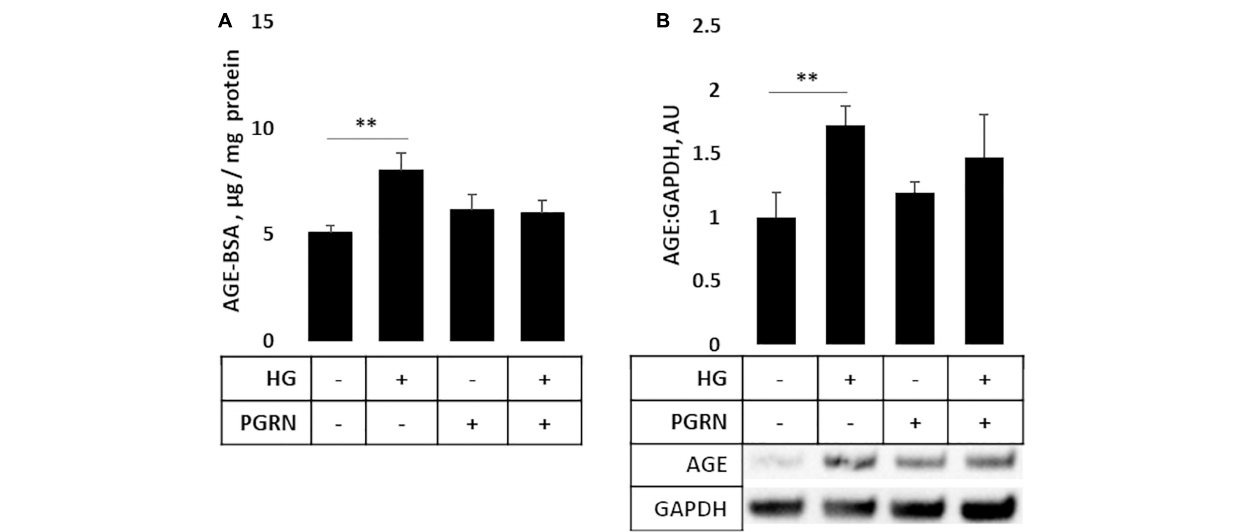
FIGURE 5 | Protein turnover in cortical neurons treated with high glucose and PGRN. (A) Cells incubated with high-glucose medium and progranulin for 72 h were treated with 50 µ g of AGE-BSA during the remaining 6 h before harvest. Remaining AGE-BSA was measured by fluorescence (360 nm excitation, 460 nm emission) and calculated using a standard curve. High glucose increased AGE-BSA levels from 0.025 ± 0.002 µ g/mg protein to 0.040 ± 0.004 µ g/mg protein. PGRN was not significantly higher than control (0.031 ± 0.004 µ g/mg protein), and no difference was observed due to high glucose alongside PGRN treatment (0.032 ± 0.003 µ g/mg protein). N = 5-6 samples. (B) Western blot analysis of samples in (A) . Increased AGE-BSA in high glucose from 1.000 ± 0.197 to 1.726 ± 0.144, indicative of reduced protein turnover, was seen. PGRN prevented the change due to glucose concentration (from 1.198 ± 0.081 to 1.473 ± 0.746) without significantly increasing from control samples ( p = 0.792). N = 5-6 samples. ∗∗ p < 0.01.